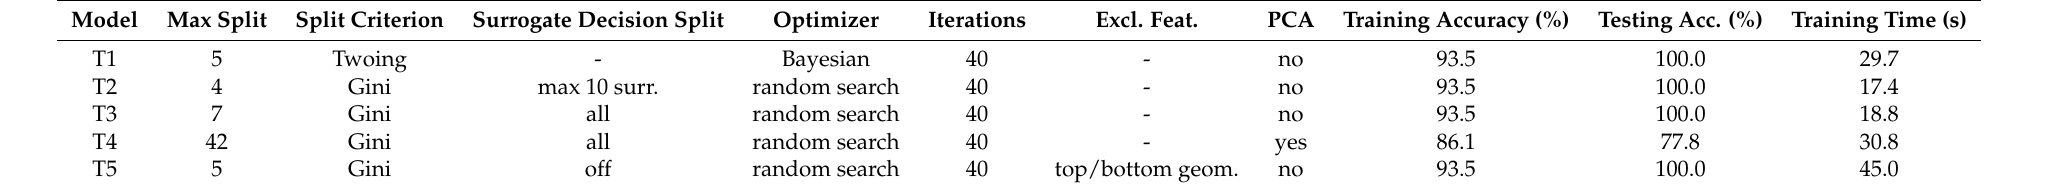
Table 5. Features of the DT models, and relevant accuracies achieved. Excl. feat. = excluded